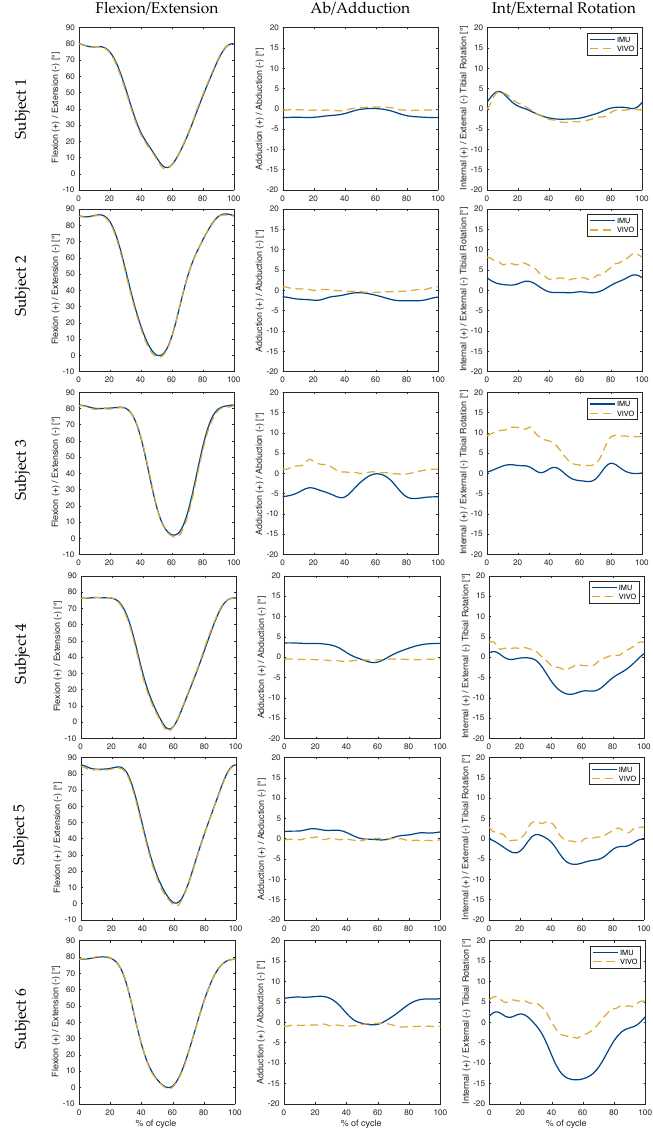
Figure 5. Sit-to-Stand-to-Sit Sequence: Knee joint angles were plotted over the progression (expressed as a percentage) of one complete gait cycle. The solid blue line illustrates the angles estimated using inertial data. The dashed gold line illustrates the ground truth angles performed by the joint simulator. Each row represents one subject, while each column presents rotations in a different plane relative to the femoral coordinate